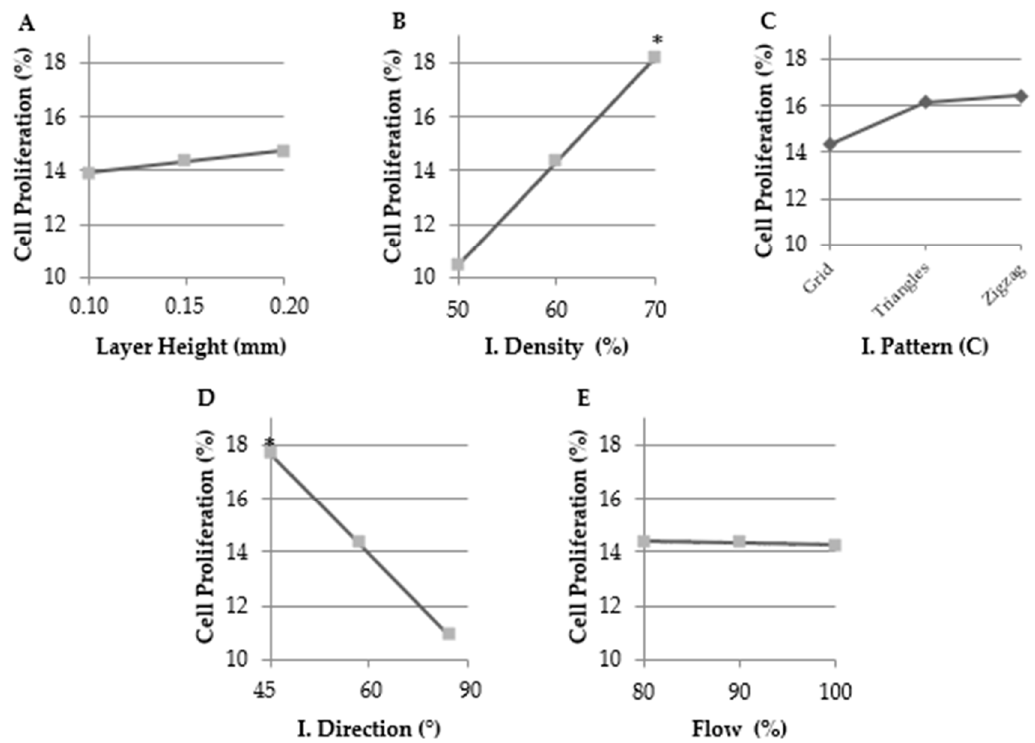
Figure 3. Main effect plots for each parameter on cell proliferation rate obtained through Quantum XL software. ( A ) Layer height. Samples printed with 60% infill density, grid infill pattern, 60 ◦ infill direction and 90% flow. ( B ) Infill density. Samples printed with 0.15 mm layer height, grid infill pattern, 60 ◦ infill direction, and 90% flow. The value of 70% significantly increased cell proliferation. ( C ) Infill pattern. Samples printed with 0.15 mm layer height, 60% infill density, 60 ◦ infill direction, and 90% flow. Zigzag pattern showed a light trend to obtain a higher proliferation rate. ( D ) Infill direction. Samples printed with 0.15 mm layer height, 60% infill density, grid infill pattern, and 90% flow. The value of 45 ◦ significantly increased cell proliferation. ( E ) Flow. Samples printed with 0.15 mm layer height, 60% infill density, grid infill pattern, and 60 ◦ infill direction. Significant differences are indicated as * ( p < 0.05).